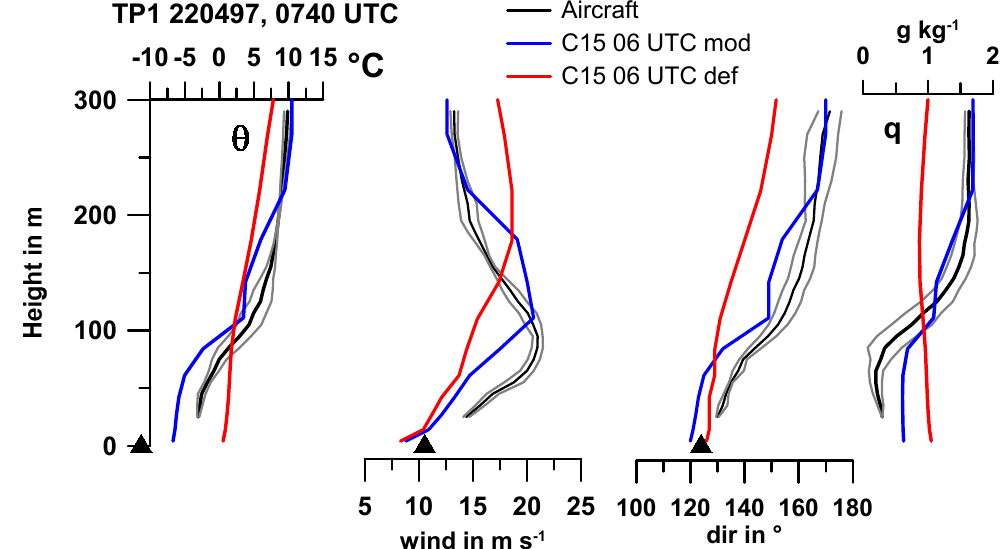
Figure 10. Averaged aircraft profiles for 07:40 UTC (black line) and simulations (def: red, mod: blue) for 06:00 UTC 22 April 1997 for profile P1 (see Table 1). The grey lines associated with the aircraft data show the standard deviation of the data in the vertical bins. The displayed variables are potential temperature ( θ ), wind speed, wind direction, and specific humidity (q). The data of AWS A4 at 07:45 UTC are shown as triangles.